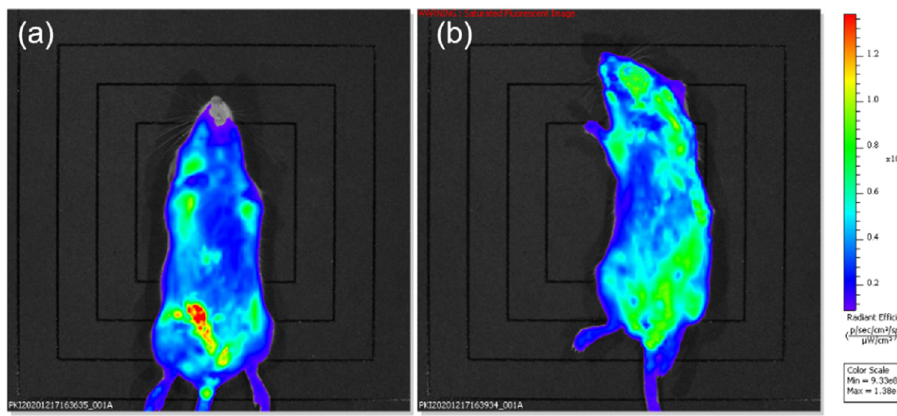
Figure 6: Fluorescent images of mice at 90 min post rectal administration with FITC - labeled AH - CS - I Ns ( a ) and PBS ( b )